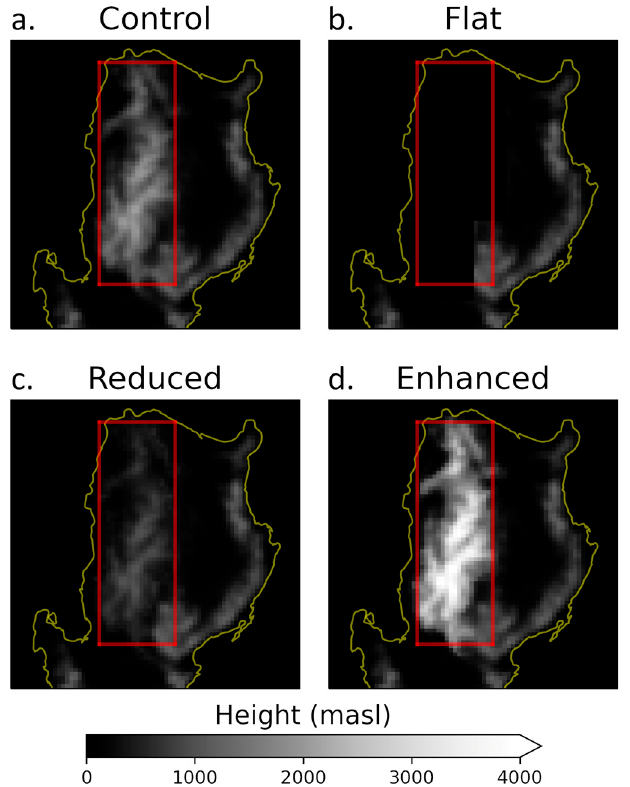
Figure 2. The orographic height in metres above mean sea level (masl) for ( a ) Control, ( b ) Flat, and ( c ) Reduced, and ( d ) Enhanced orography experiments. The CMR is enclosed in the red box.